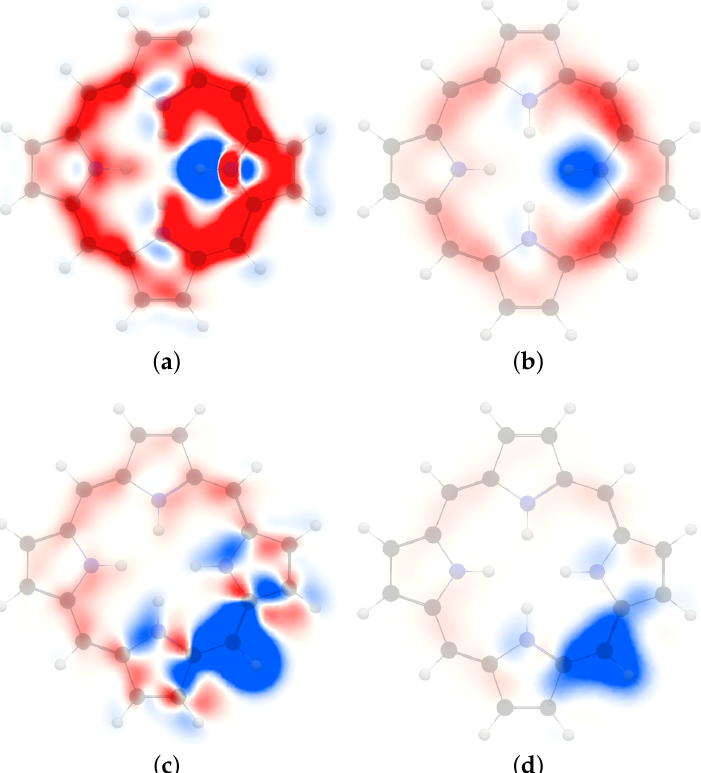
Figure 6. The isotropic 1 H NMR shielding density of the inner hydrogen of free-base isophlorin in ( a ) the molecular plane and ( b ) 1 Å above the plane. The 1 H NMR shielding density of the meso hydrogen in ( c ) the molecular plane and ( d ) 1 Å above the free-base isophlorin plane. The shielding contributions are shown in blue and the deshielding contributions in red. The employed range is [ − 0.2,0.2 ] .